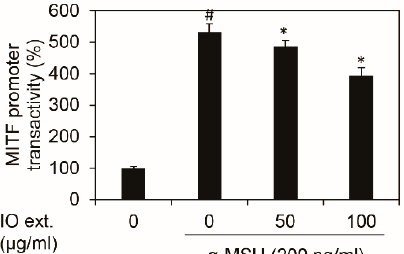
Figure 5. Effects of Inonotus obliquus extract on Mitf transcriptional activity. The Inonotus obliquus extract decreased the Mitf transcriptional activity in the B16F10 mouse melanoma cells. The transcriptional activity of Mitf was shown as a percentage of the control at the stated concentrations. The data values were obtained from the average of three independent experiments M ± SD (mean ± standard deviation). #: p < 0.05 compared with the non-treated B16F10 cells; *: p < 0.05 compared with the α -MSH-treated B16F10 cells; Mitf: microphthalmia-associated transcription factor; IO ext.: Inonotus obliquus extract; and α -MSH: alpha-melanocyte-stimulating hormone.